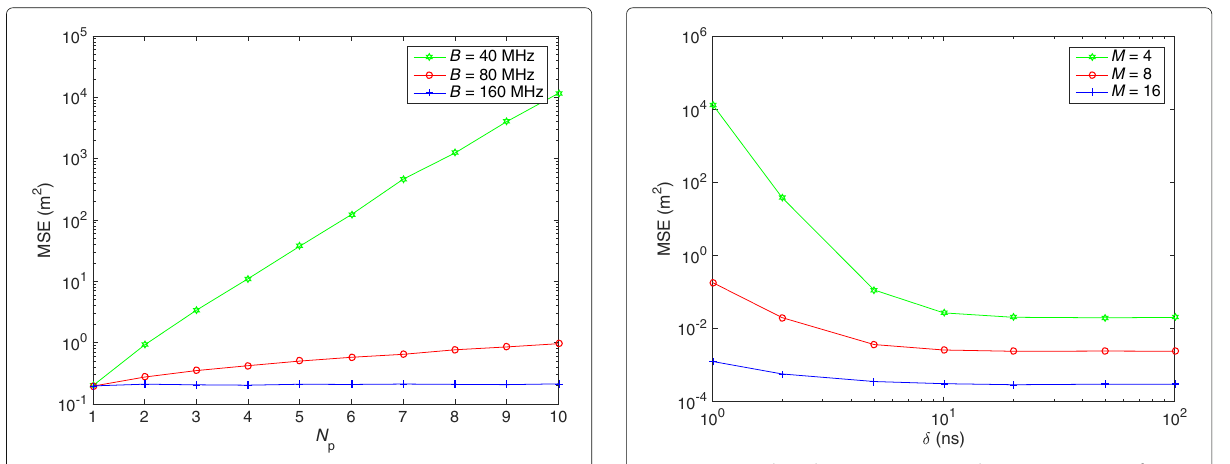
Fig. 6 Numerical result 4. MSE versus N P with B as a parameter, for M = 2, δ = 10 ns, and ρ = 0 dB